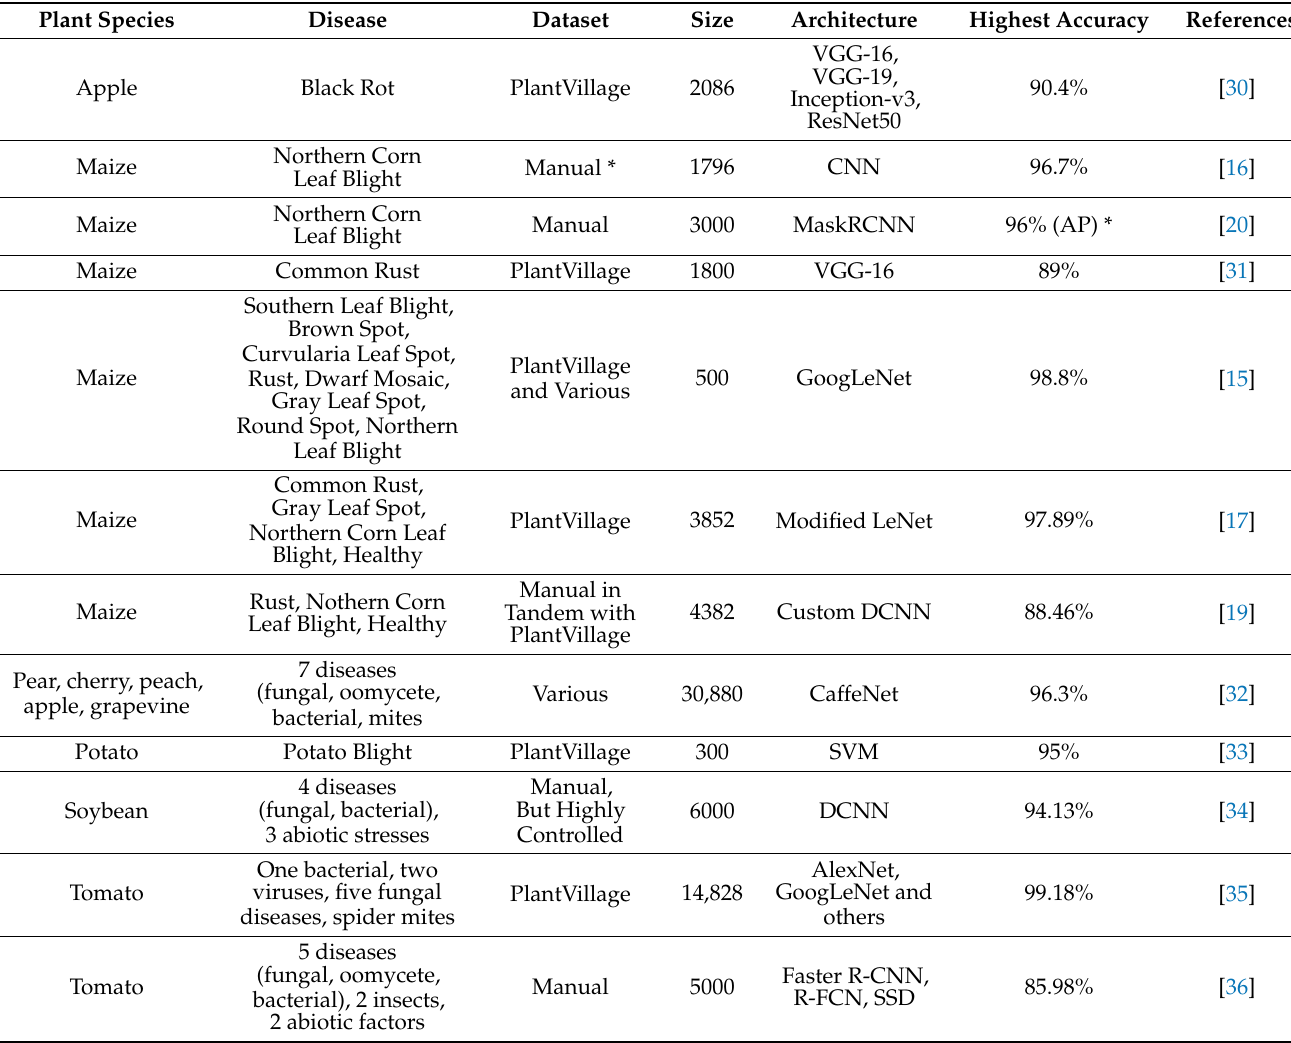
Table 1. Deep learning applications for plant disease